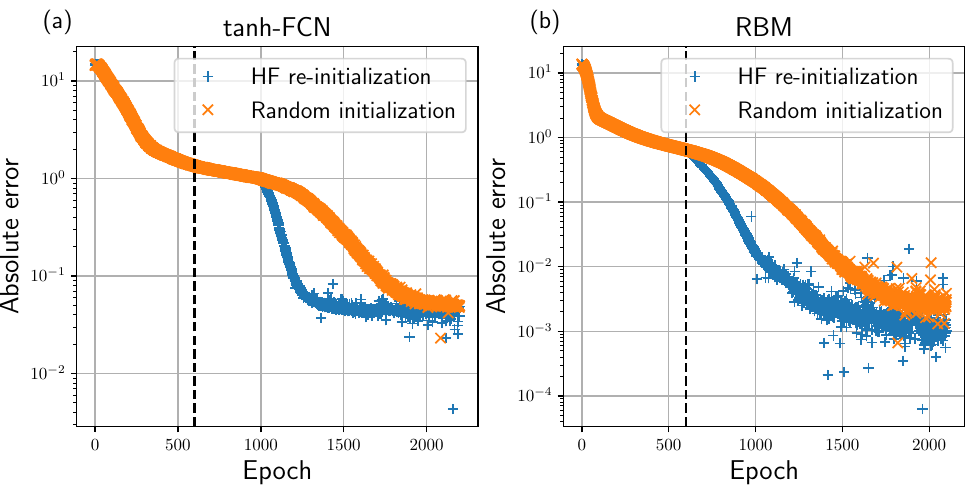
Figure 4. Effect of the Hartree–Fock (HF) re-initialization compared to random initialization for ( a ) tanh-FCN and ( b ) RBM. The H 2 O (STO-3G basis, 14 qubits) molecule is used here. The y-axis is the absolute error between the VMC energies and the FCI energy. For both methods, we start to use the HF re-initialization starting from 600-th VMC iteration marked by the vertical dashed lines. The other parameters used are N s = 2 10 4 , N h / N v = 1 and λ = 10 − 4 ×